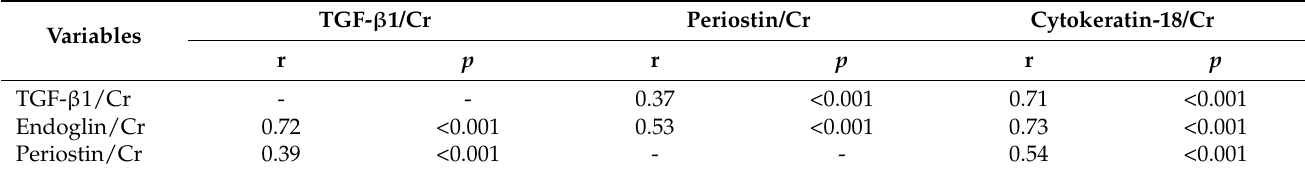
Table 5. Inter-correlations of normalized urinary biomarkers in the studied children.